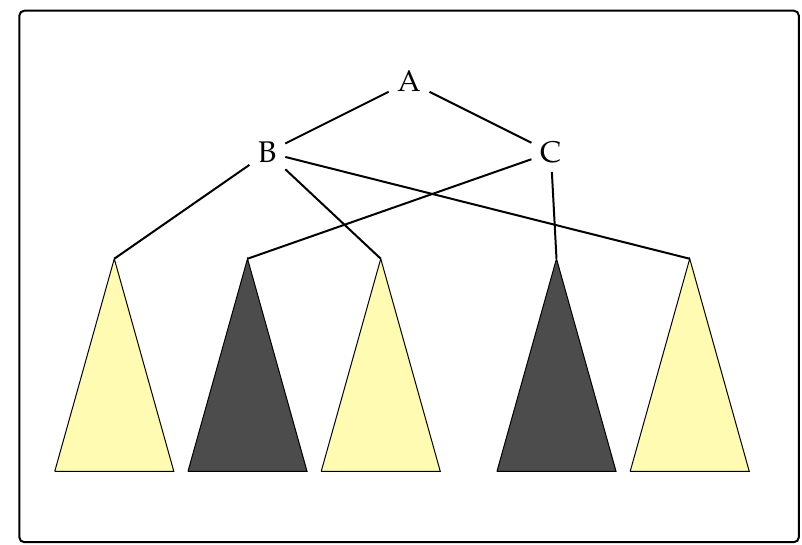
Figure 1. An illustration of a LCFRS derivation. The rule A → ϕ ( B , C ) has rank two. Nonterminal B has fan-out 3, while C has fan-out